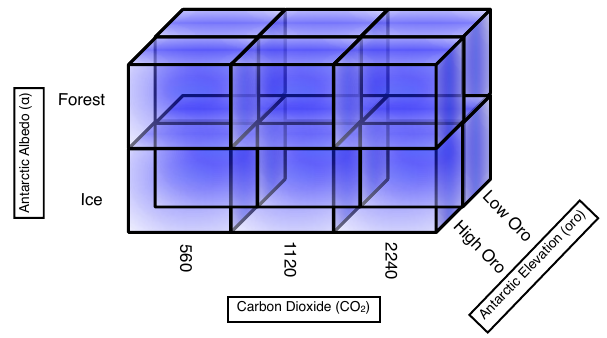
Fig. 1. Schematic describing the suite of modern and Eocene Antarctic glacier simulations that were completed in this study. Along the x-axis we plot the levels of CO 2 , along the y-axis we plot the changes in albedo over Antarctica, and along the z-axis we plot the topographical changes over Antarctica.